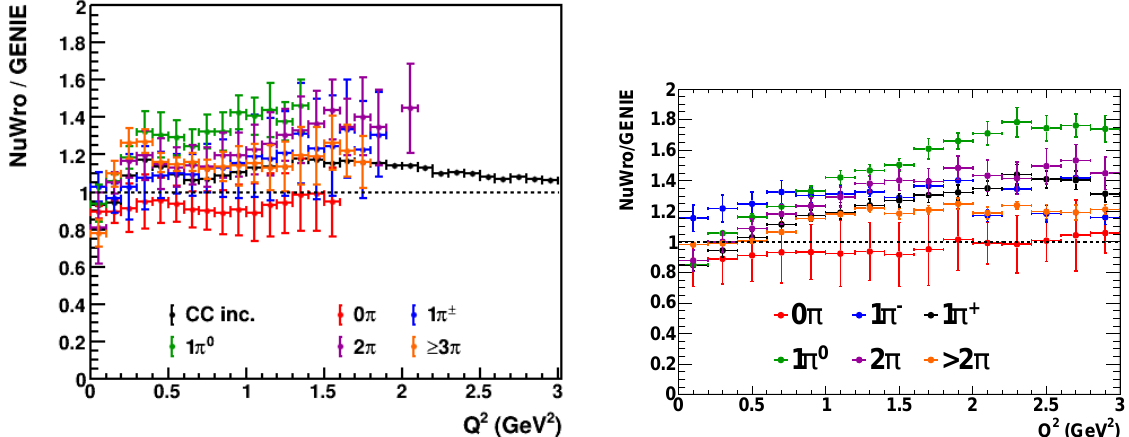
Figure 150. The ratio of the reconstructed Q 2 distributions for ν µ CC events for the NuWro and GENIE generators. Plots are Error bar represents the spread between the ratios in true ● shown for the ND-LAr ( left ) and ND-GAr ( right ), for final states including no pions (red), 1 π ± (blue), 1 π 0 (green), 2 pions (purple) and 3 or more pions